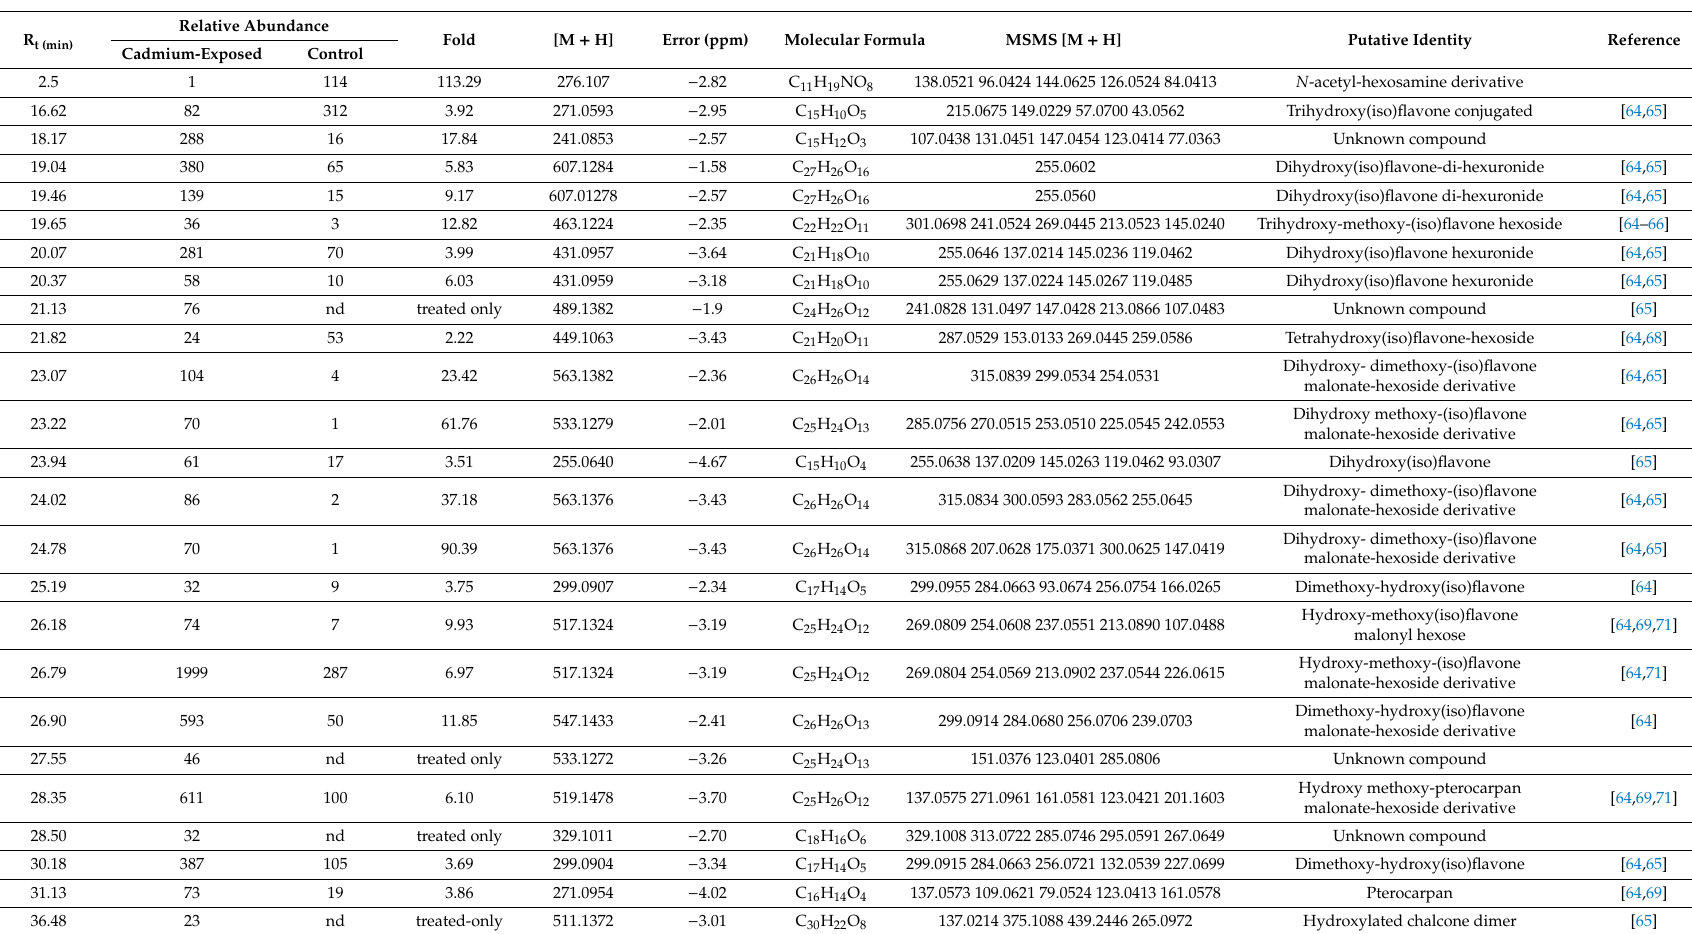
Table 3. List of di ff erentially abundant compounds in M. sativa stems after long-term Cd exposure. Data were obtained by UHPLC–MS in positive mode, with MS / MS experiments. The relative abundance of each peak in stems of control and Cd-exposed plants is based on the selected ion current and is presented as the average normalized value of two technical replicates from five biological replicates. Abbreviations: Rt, retention time; nd, not